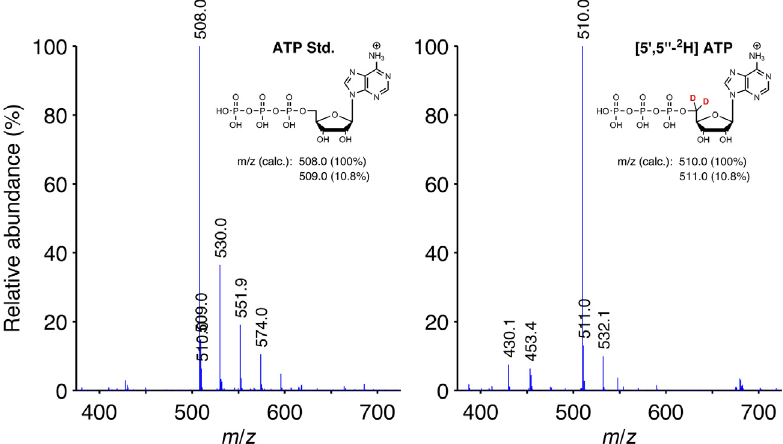
Figure 14. Mass spectra of an ATP disodium standard (left) and [5 ′ ,5 ″ - 2 H]ATP (right). The insets depict the structures of the most abundant molecular ion in each sample and list the expected m / z . The expected natural isotopic abundances are noted in parentheses. Deuterium atoms are colored